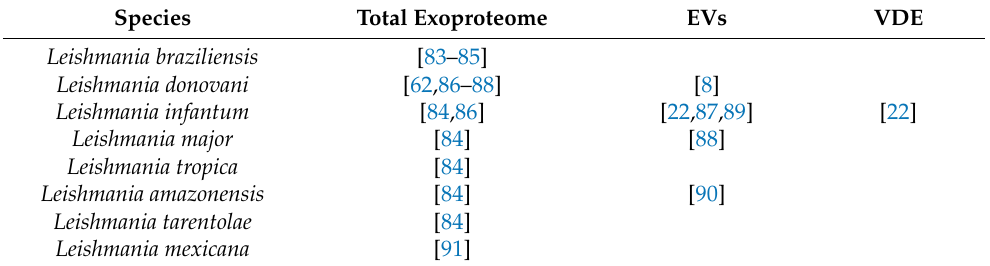
Table 1. Exoproteome studies involving proteomic characterization in Leishmania spp. Species Total Exoproteome